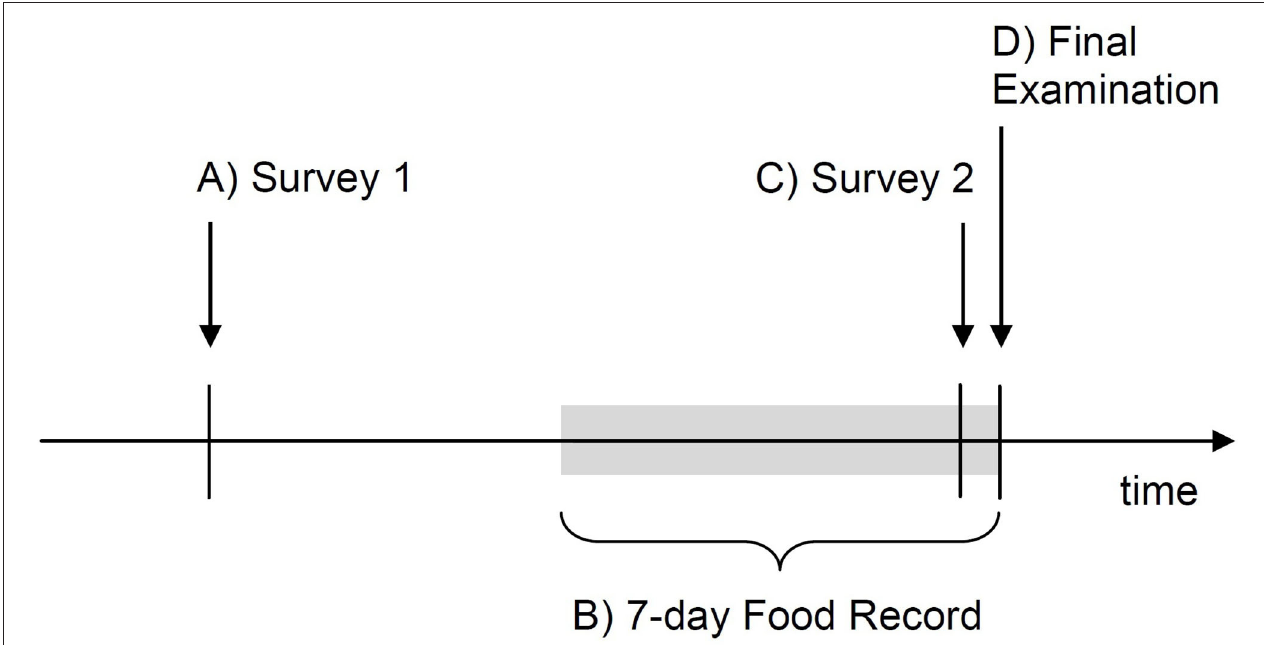
FIGURE 1 | Timeline of the study procedures. Four steps of the study are indicated with letters